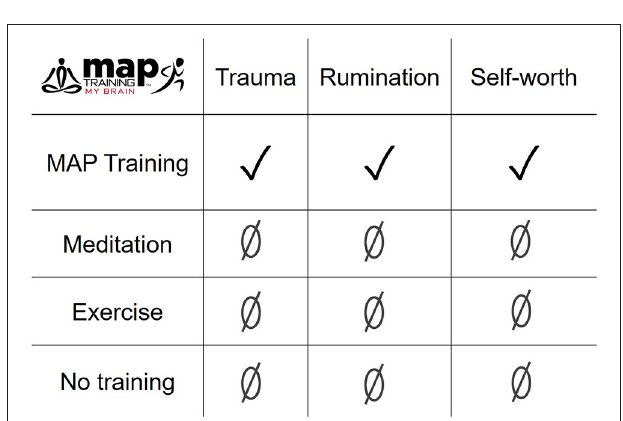
FIGURE 5 | The combination of meditation and aerobic exercise during MAP Training was more effective than either meditation or exercise alone, especially in reducing trauma-related cognitions and ruminative thoughts, and enhancing self-worth in women with a history of sexual